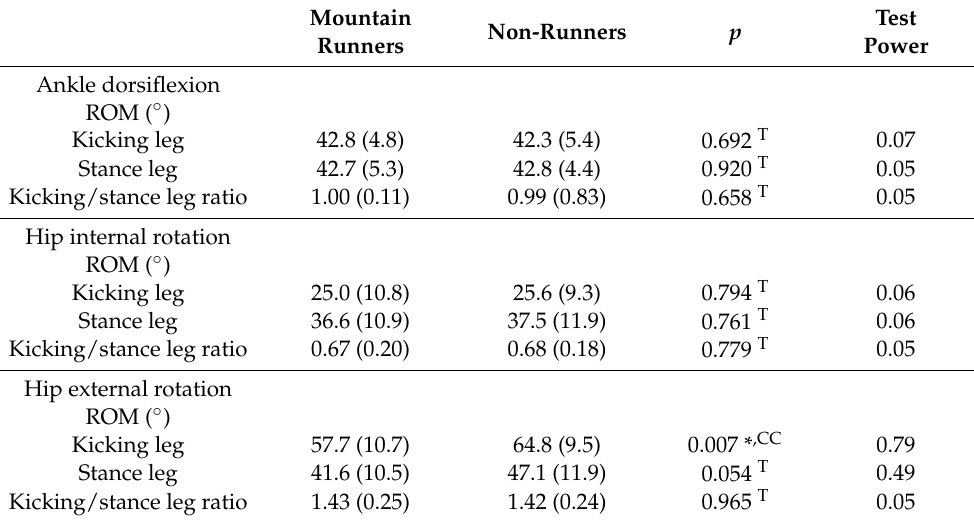
Table 3. Results (mean (SD)) of ROM